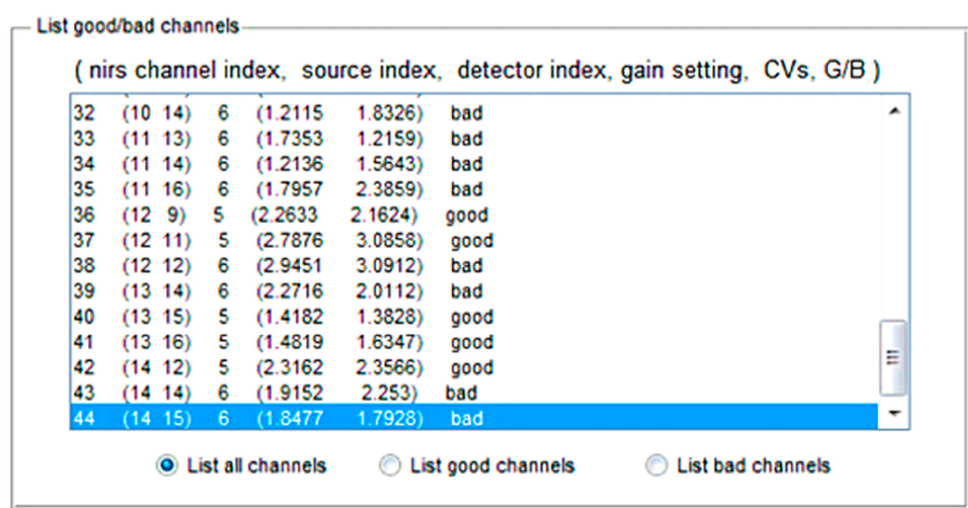
Figure 7. List of good/bad channels to remove bad channels from the analysis and signal classifica- tion.